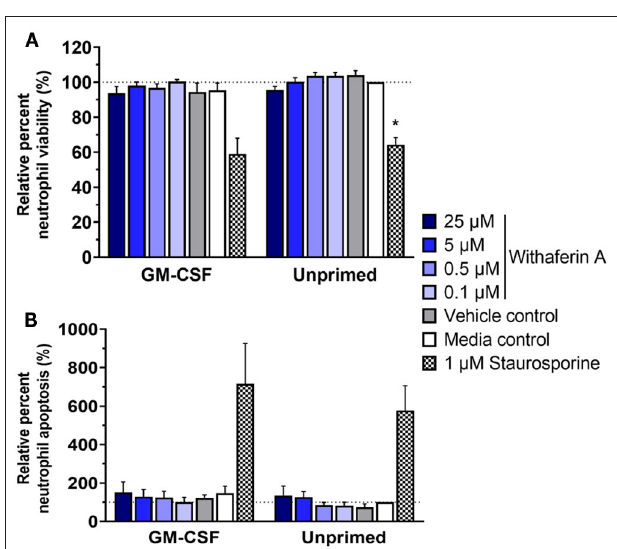
FIGURE 4 | Withaferin A does not impair short-term neutrophil viability or cause rapid neutrophil apoptosis. Mean (SEM) percentage of live (A) and apoptotic (B) neutrophils relative to media control, unprimed neutrophils following 2-h treatment of equine neutrophils under GM-CSF-primed ( n = 3 horses) or unprimed ( n = 4 horses) conditions. Flow cytometry quantification of annexin V binding and propidium iodide staining. One-way repeated measures ANOVA (Holm-Sidak multiple comparison testing); * p < 0.05 compared to media control within same priming condition.